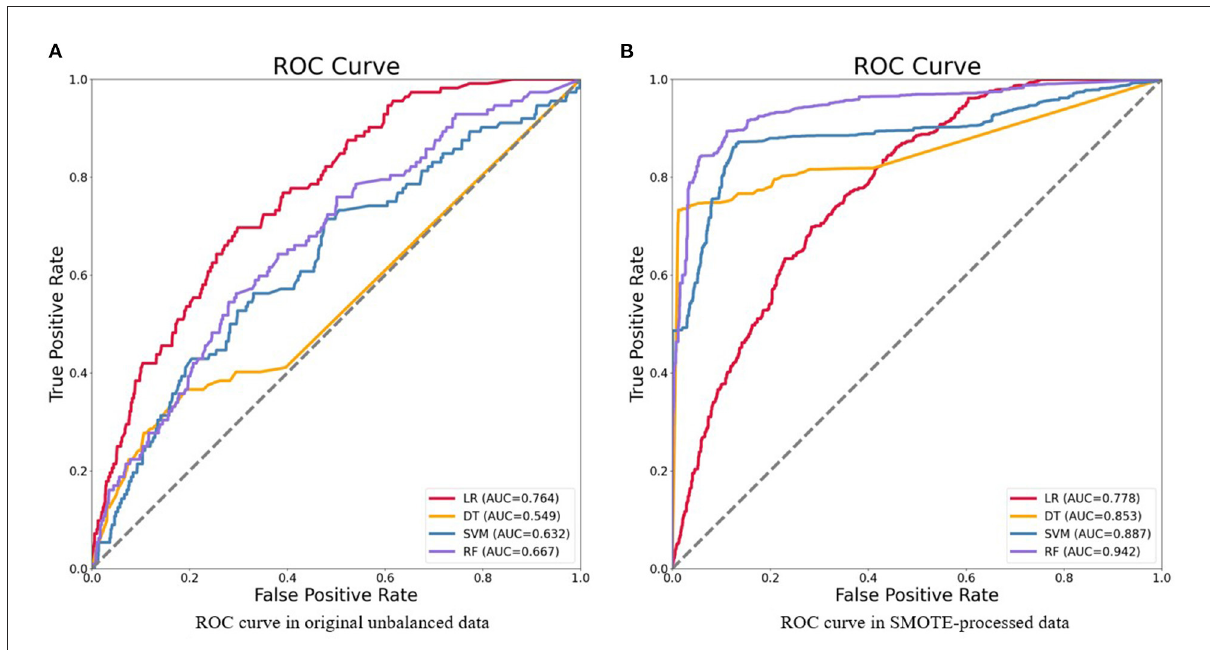
FIGURE3 Receiver operating characteristics (ROC) curve of four models for the prediction of HIV in prospective validation data. LR, logistic regression; DT, decision tree; SVM, support vector machines; RF, random forest.